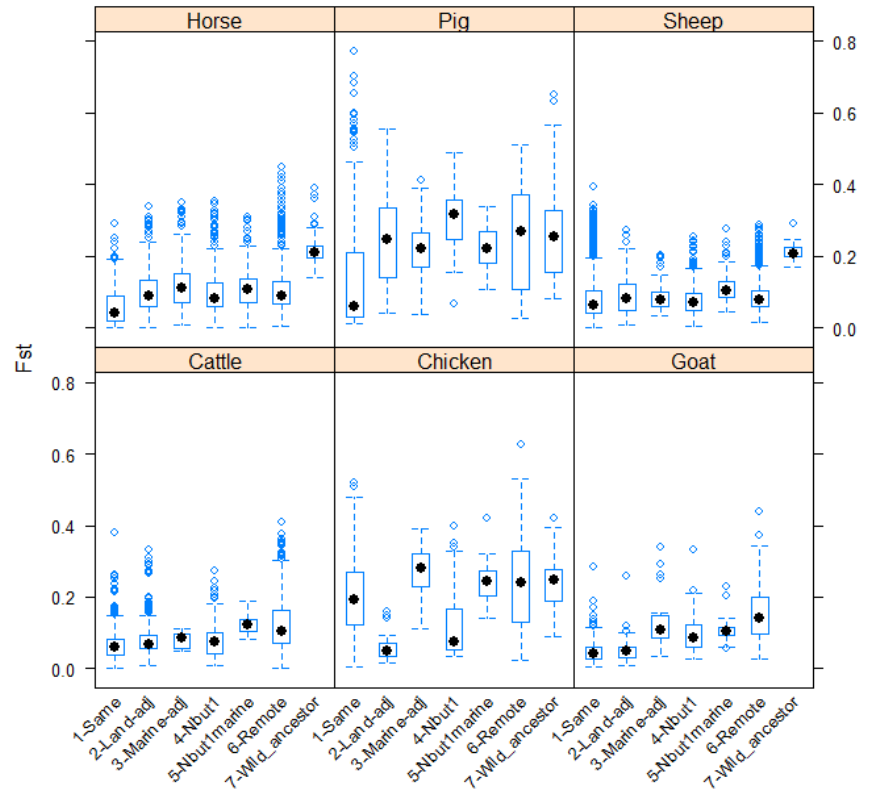
Figure 1. Boxplots summarizing, for each species, values of the F st statistic for breed pairs according to the spatial relationship of the members of the pair. Data from studies using MS methodologies.